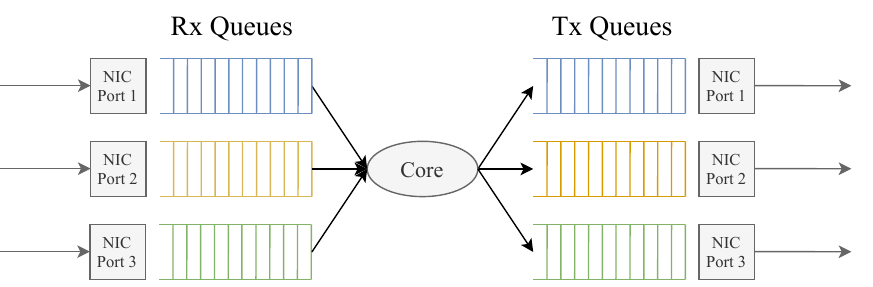
Figure 13. The topology of multiple queue evaluation.